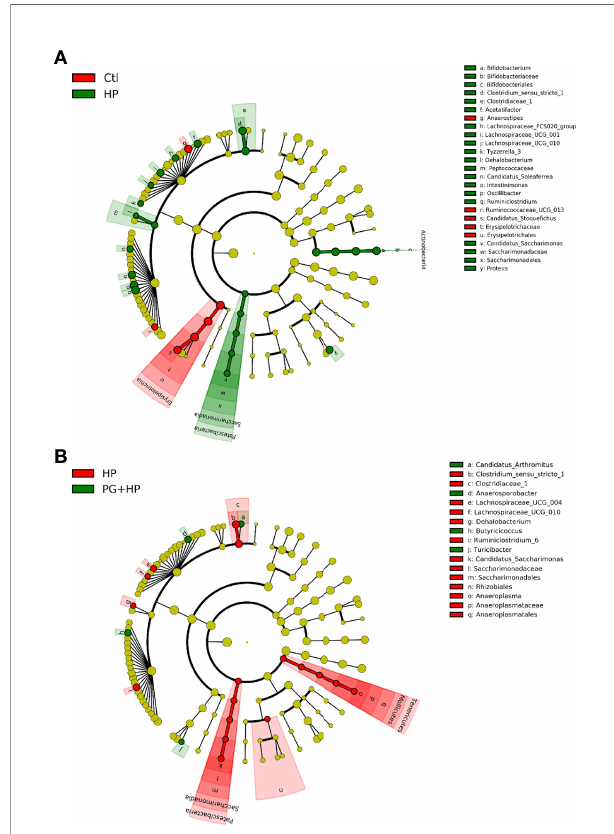
FIGURE 5 | Differences in the gut microbiota composition in P. goldsteinii MTS01-treated and H pylori -infected mice. LEfSe analysis exhibited the abundance bacterial species compared with (A) control and H. pylori ; (B) H. pylori and P. goldsteinii MTS01+ H. pylori